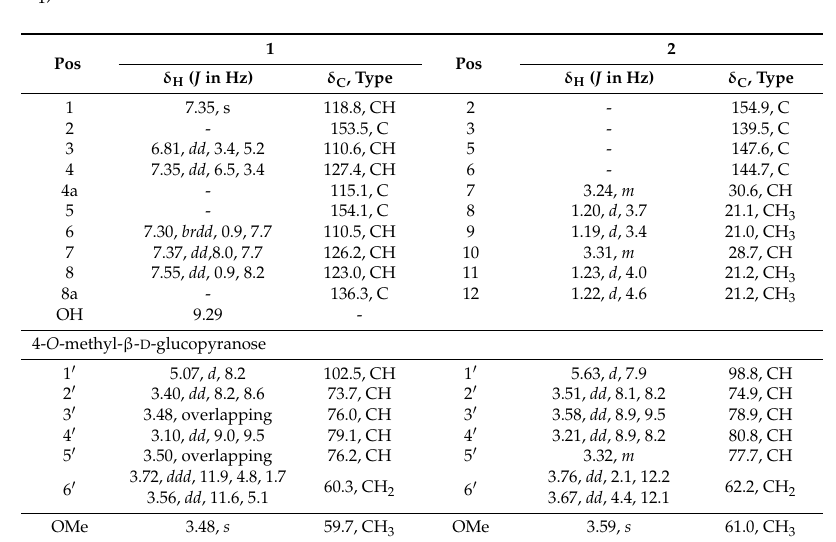
Table 1. 1 H- and 13 C-NMR data for akanthol ( 1 ) in (500 MHz, DMSO- d 6 ) and akanthozine ( 2 ) (500 MHz, Methanol- d 4